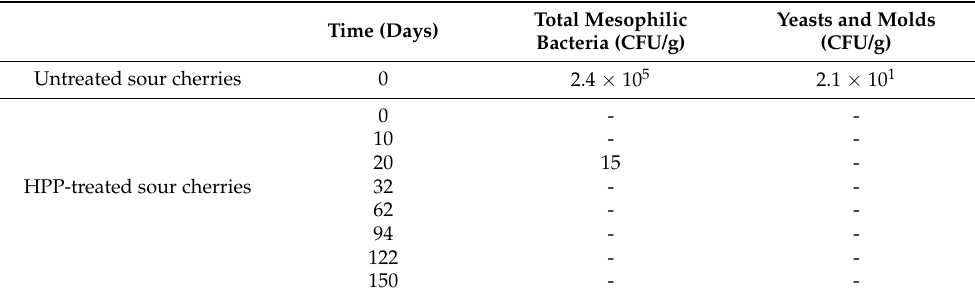
Table 1. Total mesophilic bacteria and yeast and mold counts (CFU/g) in raw and HPP-treated sour cherries during refrigerated